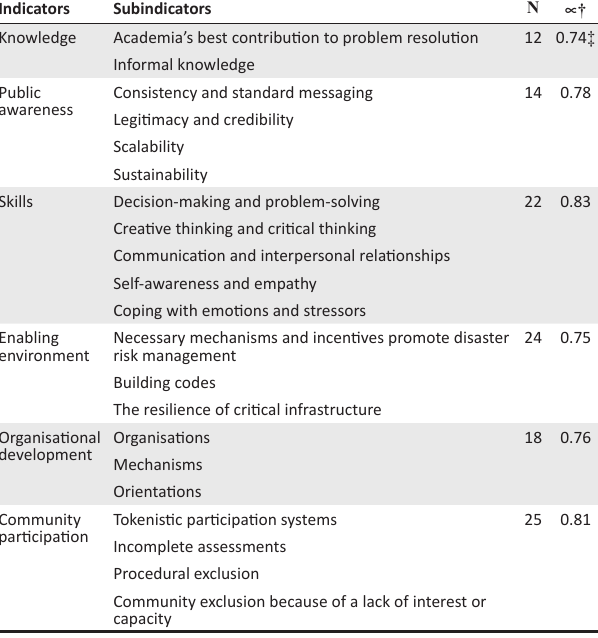
TABLE 6: Criteria and basic indicators of earthquake risk reduction.